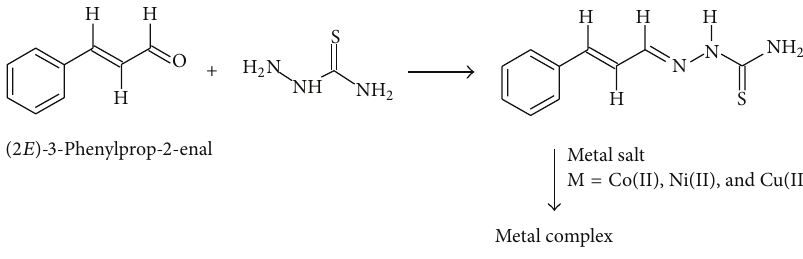
Scheme 1: Synthesis of ligand and its complexes.